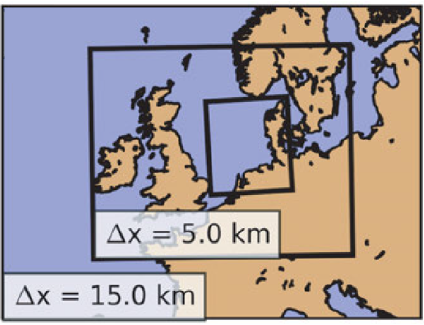
Figure 3. Locations of the three WRF model domains with grid sizes of 15, 5, and 1.6 km, respec- tively